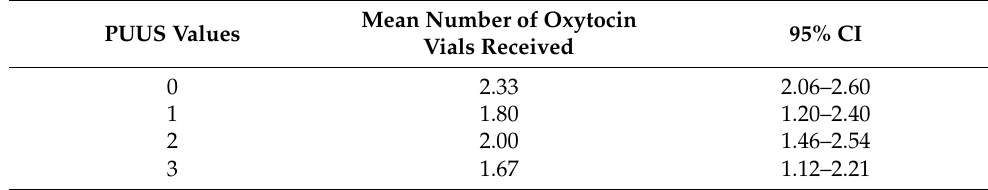
Table 11. The PUUS values of patients regarding the number of oxytocin vials received during the third stage of